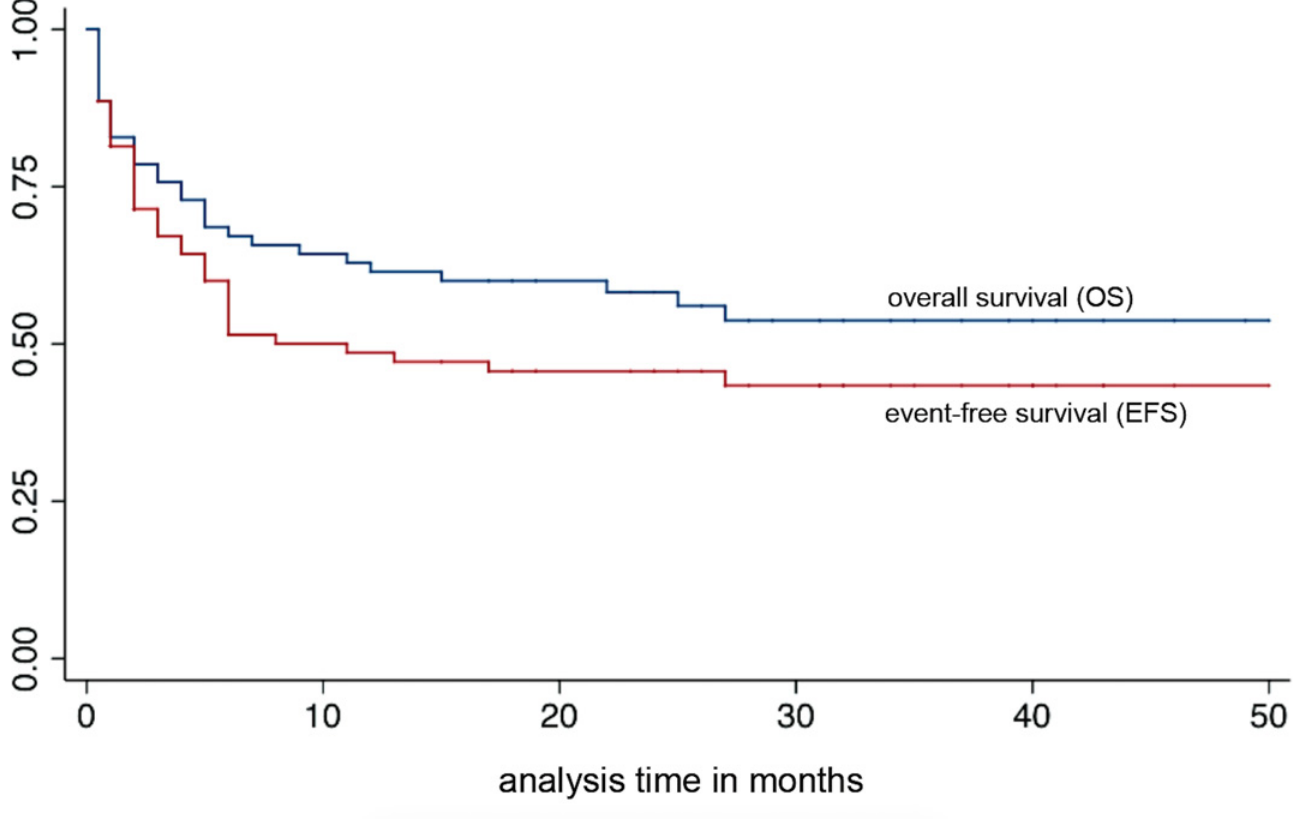
Fig 3. Kaplan-Meier curves demonstrating probability of overall (OS) and event-free survival (EFS) of 70 children and adolescents with KS.